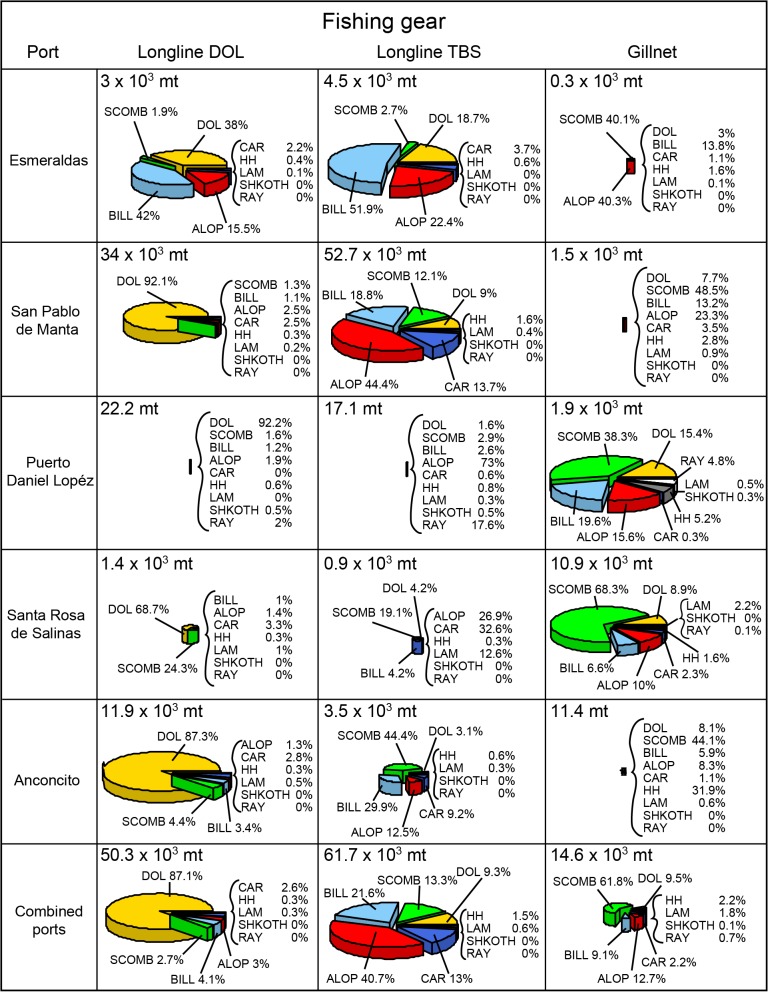
Catch composition of the Ecuadorian artisanal fishery for large pelagics.The information is presented by landing port and type of fishing gear (longline for dolphinfish (LL-DOL), longline for tuna-billfish-sharks (LL-TBS), and surface gillnets (GN)). The species codes can be found on Table 1. Catch is an underestimate of the fleet total; see text for details. Pie chart size has been scaled by gear, within each port, and therefore pie chart sizes cannot be compared across ports.